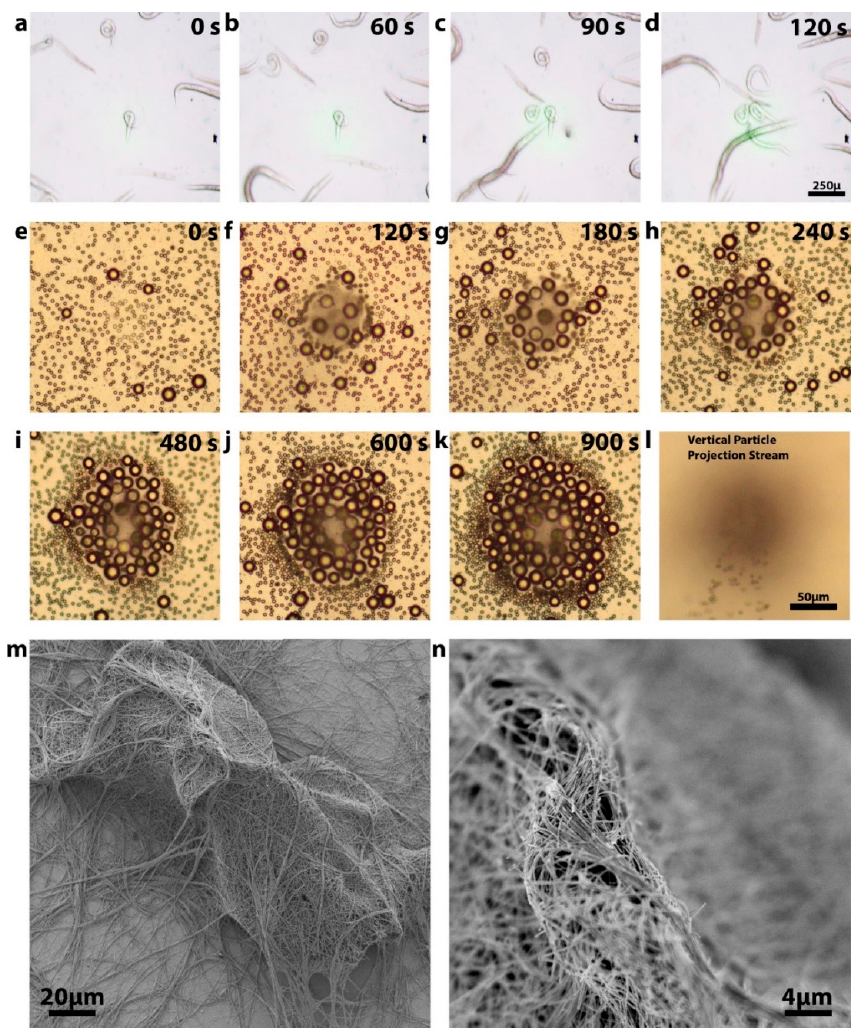
Figure 4. Demonstration of the extraordinary dynamic range of opt-fluidic manipulation and Figure4. Demonstrationoftheextraordinarydynamicrangeofopt-fluidicmanipulationandapplication application to the assembly of complex structures. ( a–d ) Capturing live worms using 40 mW power. to the assembly of complex structures. ( a – d ) Capturing live worms using 40 mW power. Worm length Worm length varied from 50 to 200 um. ( e–l ) Selective capturing of large particles and their multi- varied from 50 to 200 um. ( e – l ) Selective capturing of large particles and their multi-layer assembly. layer assembly. ( m,n ) A multi-layer silver nanowire structure built using trapping and levitation. ( m , n ) A multi-layer silver nanowire structure built using trapping and